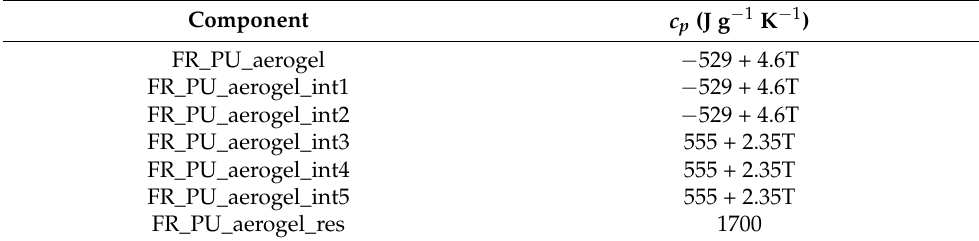
Table 3. Heat capacities of the condensed phase